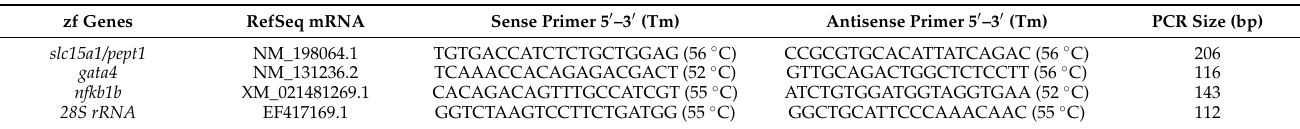
Table 2. Details of the primer sequences adopted for qPCR assays. Forward and reverse nucleotide sequences with melting temperatures (Tm) are reported, along with the reference Zebrafish genes and mRNA sequences (RefSeq mRNA) used for primer design. The PCR product size of the generated amplicons is also